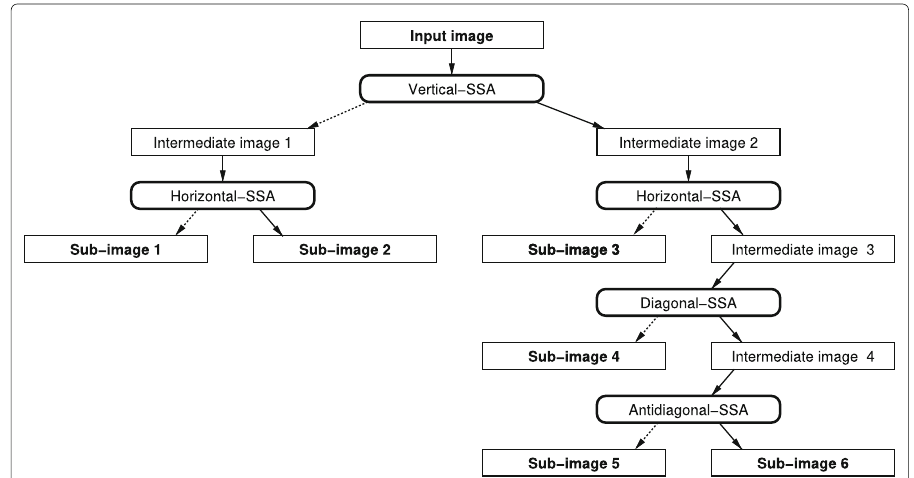
Fig. 10 The structure of the “ SSA-iSBD6-channelfilterbank ” implemented as an extension of the “ SSA-iSBD 4-channelfilterbank ,” type “ vertical/horizontal ”